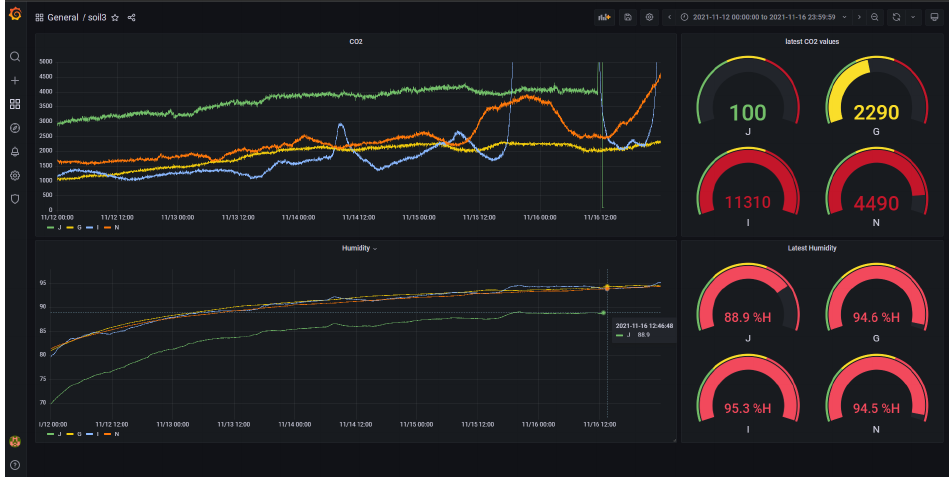
Figure 6. Live data dashboard viewed through Chrome internet browser.